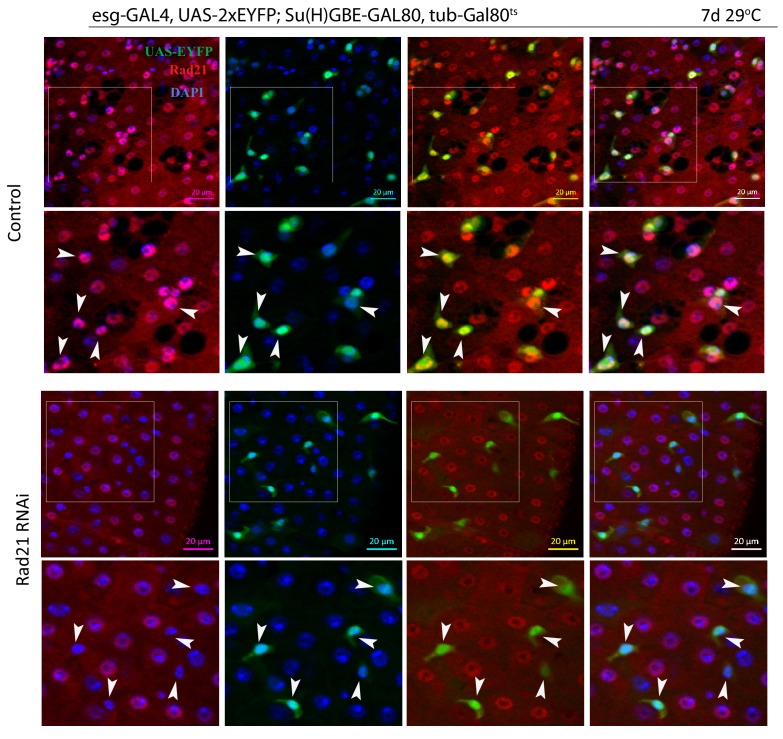
A Esgts midguts expressing UAS-EYFP alone (control) or expressing rad21RNAi.Samples were stained for GFP and Rad21. Rad21 expression (Control, second raw) or Rad21 knock down efficiency (Rad21 RNAi) is indicated by white arrowheads. Scale bars, 20 µm.